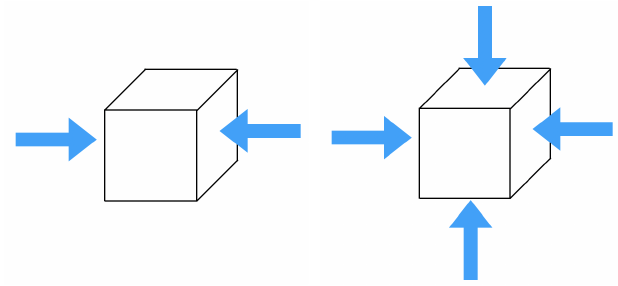
Figure 2. Uniaxial and equibiaxial compression tests